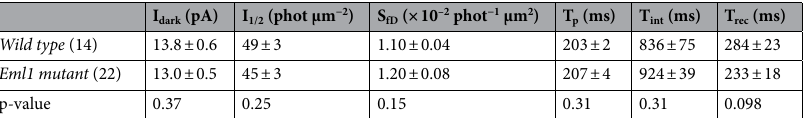
Table 2. Rod outer segment suction recording analysis parameters. I dark , saturated response amplitude measured at the plateau. I 1/2 , intensity required to produce half of the saturated response. S fD , dark-adapted sensitivity. T p , time to peak of a dim flash response. T int , integration time of the response. T rec , recovery time constant during response shut off. All values are given as Mean ±